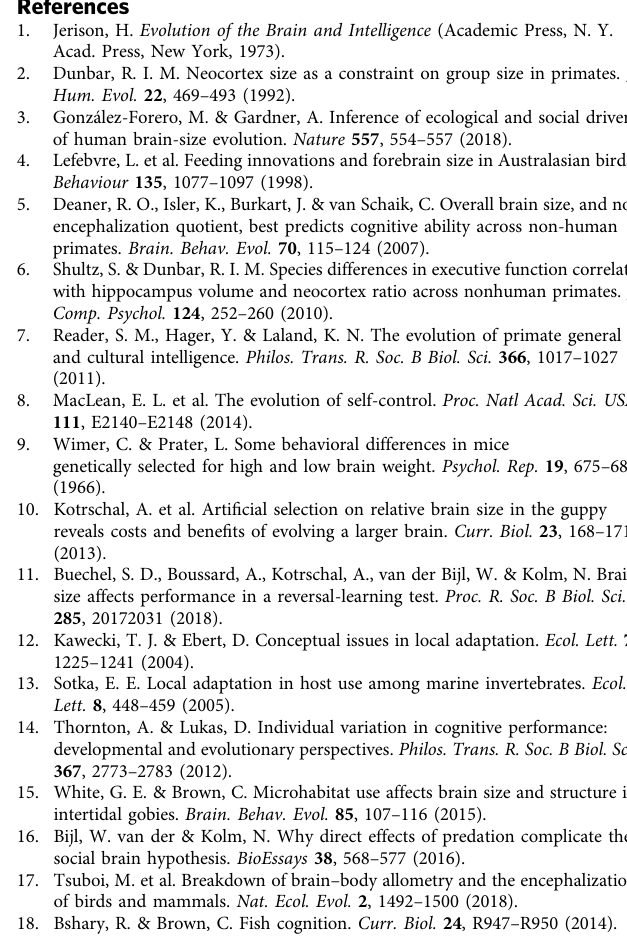
Fig. 1. Brain tissue was then weighed with an analytical balance with a readability of up to 0.0001 g. The samples were then fi xed for 24h in 4% paraformaldehyde (PFA) solution at 4°C. The brain tissue was then transferred to PBS 0.1% sodium azide solution and stored at 4°C. Three brain part samples that belong to